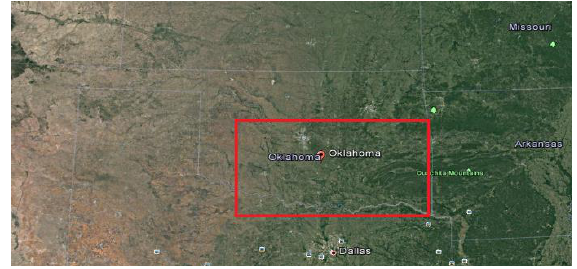
Figure 2. Study area in south Oklahoma. Table 2: Information about study area. Study site